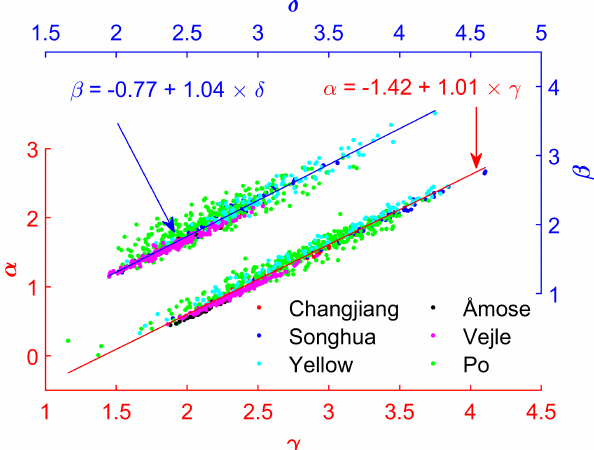
Figure A3. Linear relationships between γ – α and δ – β using data of all six rivers. Similar to Fig. 2, but a uniform Manning’s coefficient of 0.03 was used.